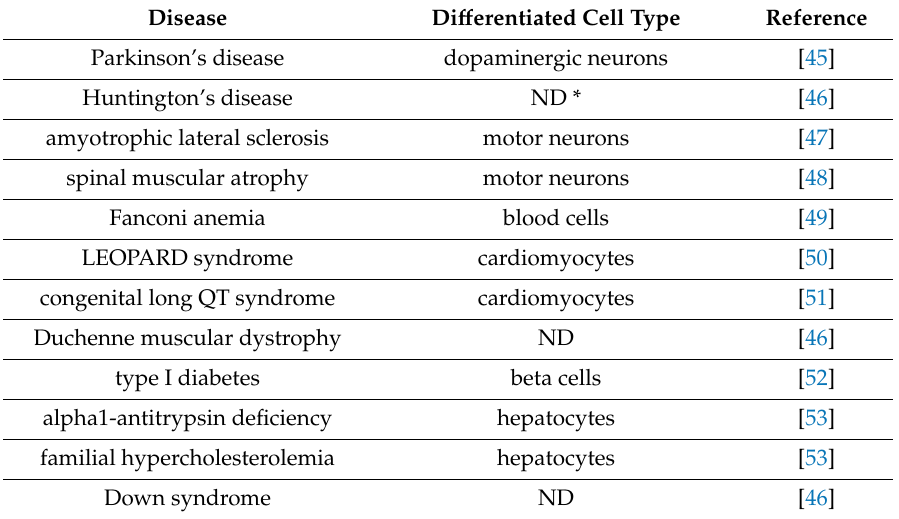
Table 2. Examples of terminally di ff erentiated cells generated from induced pluripotent stem (iPS) cells.